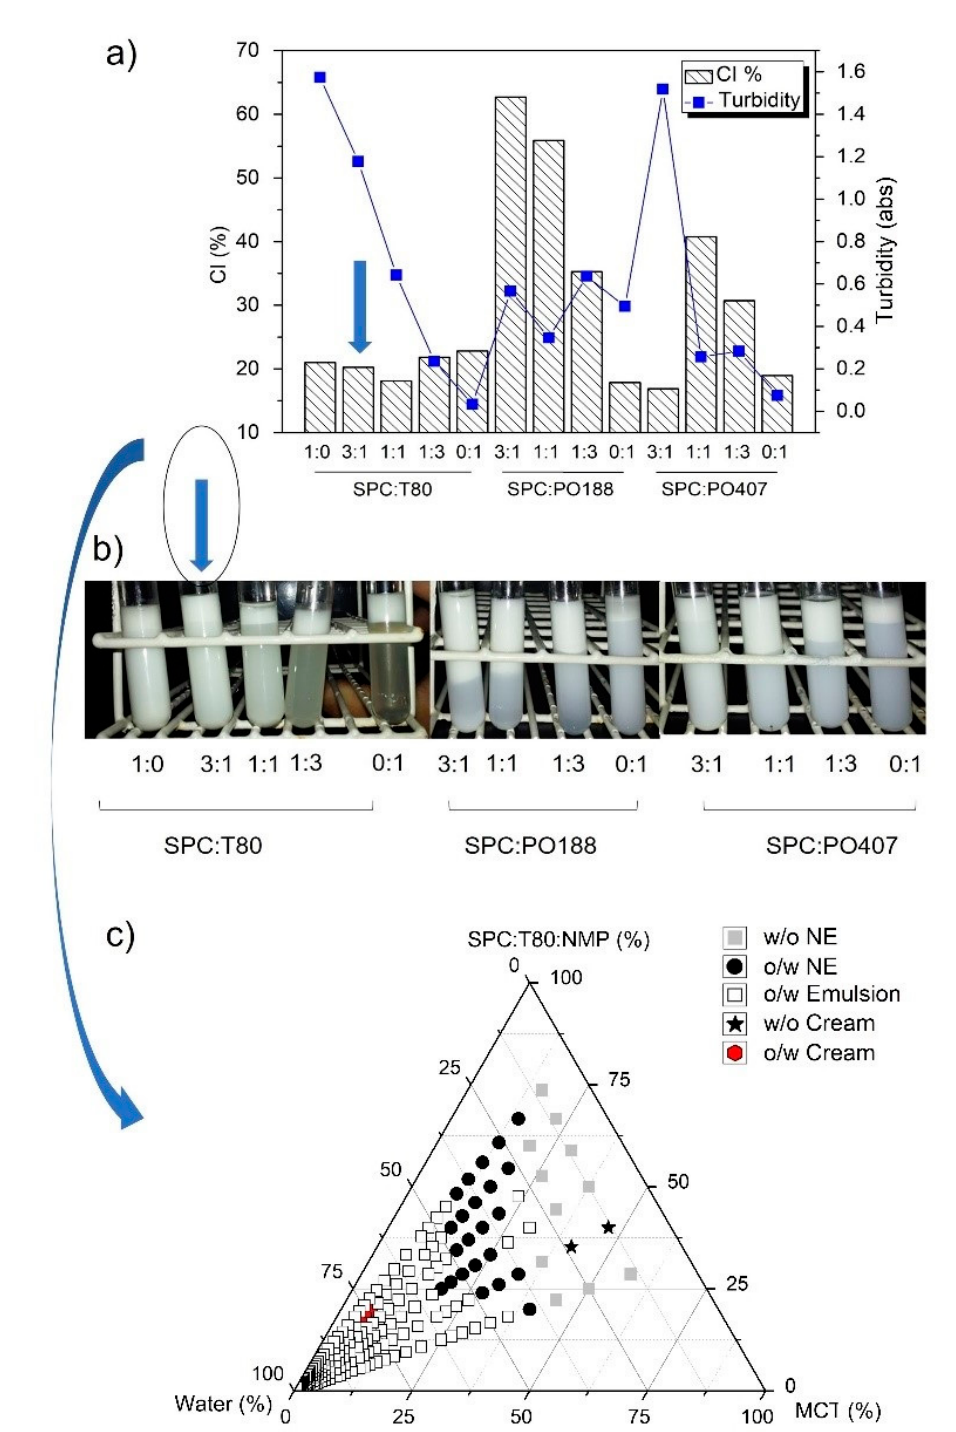
Figure 1. Formulation studies for assessing the surfactant composition: SPC:T80, SPC:PO188, SPC:PO407. ( a ) Creaming index (CI) and Turbidity of different emulsions; ( b ) Images of each tested formulation; ( c ) Pseudo-ternary phase diagram using the SPC:T80 (3:1 w/w ).